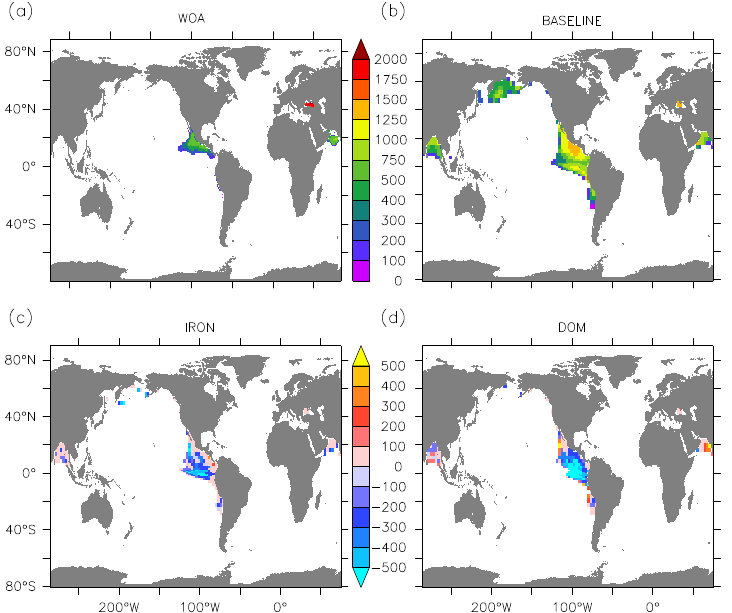
Fig. 6. Average thickness (m) of the low-O 2 water layer ([O 2 ] <5mmolm − 3 ) computed from the corrected WOA annual means, Bianchi et al. (2012) dataset (panel a ) and for the BASELINE simulation (panel b ). Panel (c) and (d) are thickness changes of the (c) IRON and (d) DOM simulations relative to the BASELINE simulation. Figure shows averages over 150 model years. Thickness changes are in metres with negative numbers denoting reductions relative to the BASELINE